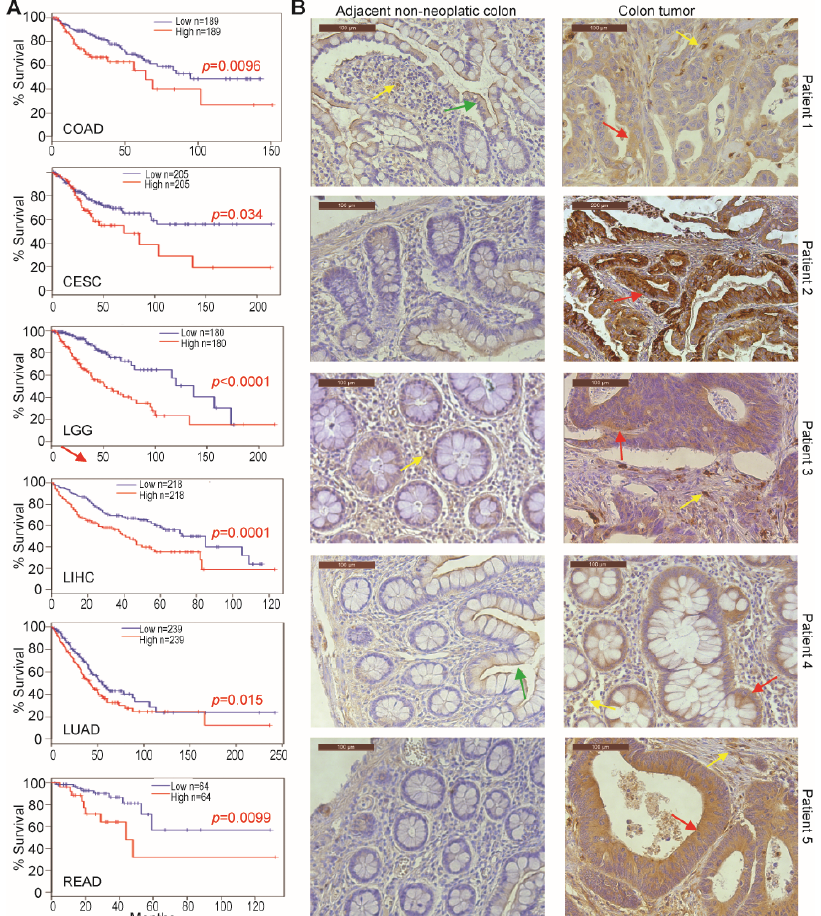
Figure 1. OPN protein level in non-neoplastic colon and colon carcinoma. ( A ) OPN mRNA expression level and survival datasets were extracted and plotted for survival. CESC: Cervical squamous cell carcinoma and endocervical adenocarcinoma; COAD: Colon adenocarcinoma; LGG: Brain lower grade glioma; LIHC: Liver hepatocellular carcinoma; LUAD: Lung adenocarcinoma; READ: Rectum adenocarcinoma. ( B ) Human colon carcinoma ( n = 5) and matched non-neoplastic colon ( n = 5) were stained with OPN-specific antibody. Green arrows indicate normal colon epithelium. Yellow arrows indicate myeloid cells. Red arrows indicate carcinoma cells. Shown are representative images. Scale bar = 100 μ M. To investigate the cellular source of OPN in colorectal cancer patients, we mined scRNA-Seq raw datasets deposited in the GEO database (GSE146771) [37]. Colorectal tu- mor-resident immune cells were annotated (Figure 2A). Cellular subtype analysis demon- strated that principally myeloid cells, as well as innate lymphoid cells (ILCs) and malig- nant cells, drove increased OPN levels (Figure 2B). Expression of SPP1 was enriched in colorectal tumor tissues compared to matched PBMC and healthy colon (Figure 2C). We then sought to elucidate whether SPP1 expression was driven by expansion of a subset of